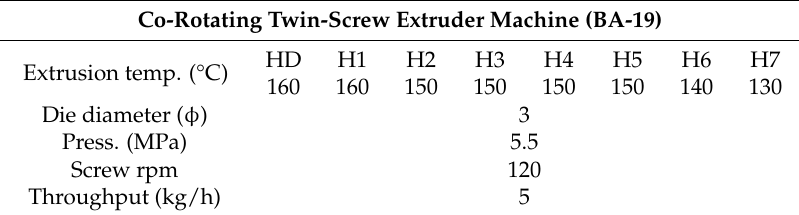
Table 2. Co-rotating intermeshing twin-screw extruder settings.